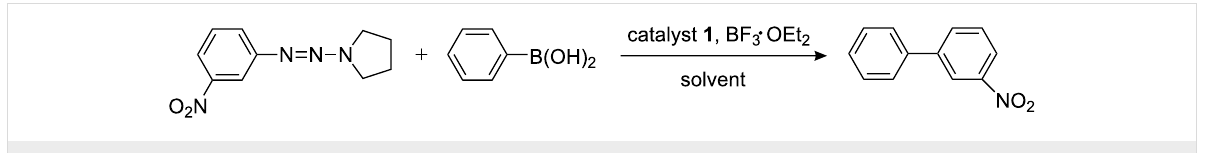
Scheme 2: Reaction of 1-(3-nitrophenyl)-2-(pyrrolidin-1-yl)diazene and phenylboronic acid.